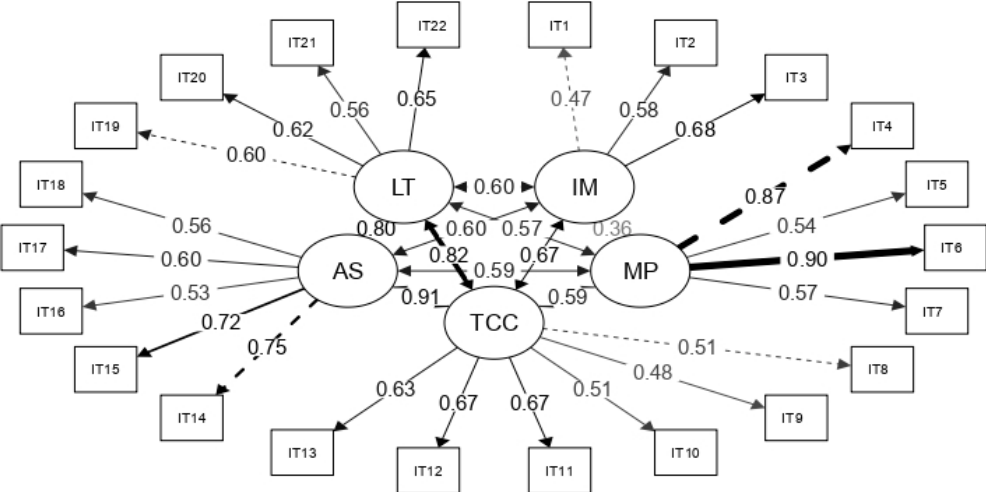
Figure 1. Path diagram of the five-factor model of oral skill. Note: The boxes represent observed variables (items) and the circles latent variables (IM = interaction management, MP = multimodality and prosody, TCC = textual coherence and cohesion, AS = argumentative strategies, and LT = lexicon and terminology). The arrows are the paths with their standardized weights, the double-headed arrows are the correlations between latent variables, the discontinuous lines specify the items that set the metrics and a greater thickness of lines indicates greater weights or correlations.